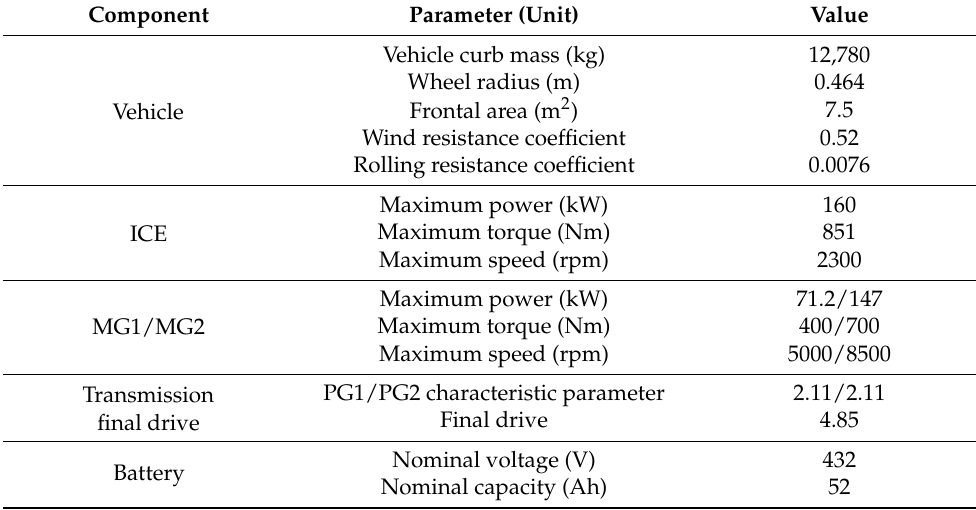
Figure 1. Powertrain configuration. Table 1. Main parameters of HEUB.